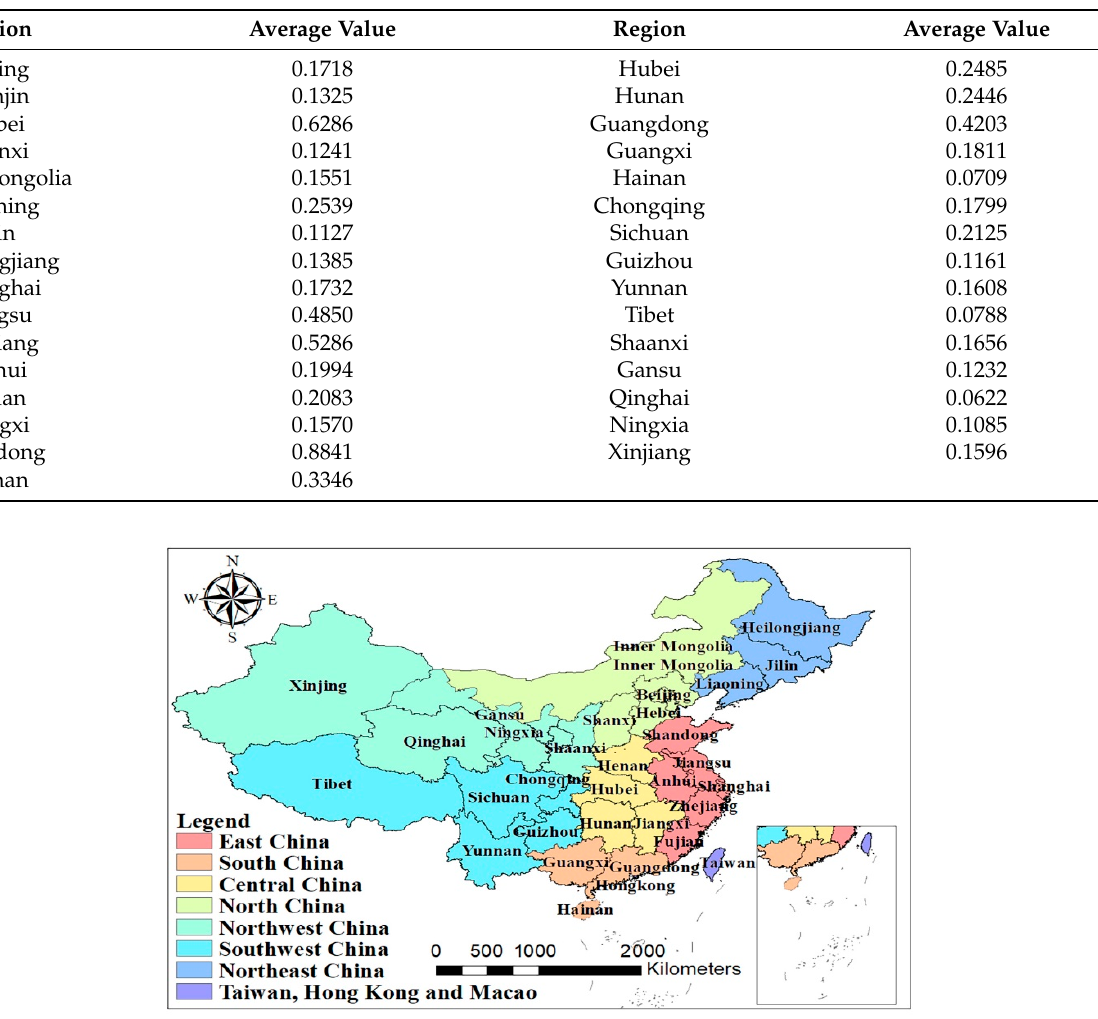
Table 4. Average values of development indicators of various provinces’ FAPSC.